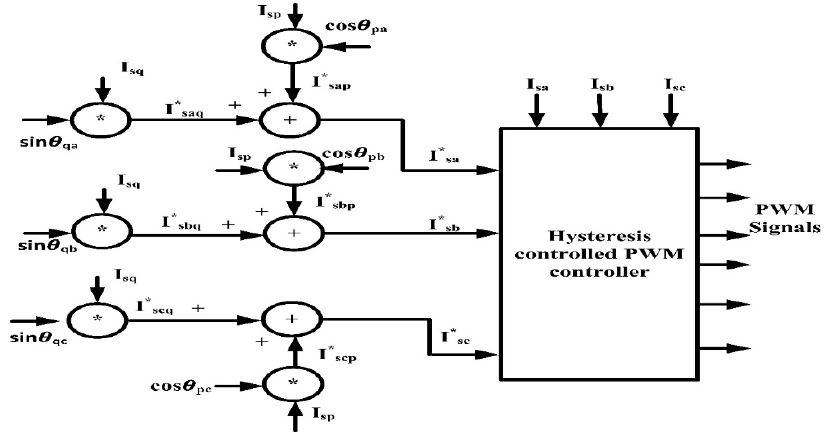
Figure 8. Gate pulse generation (* indicates reference value)